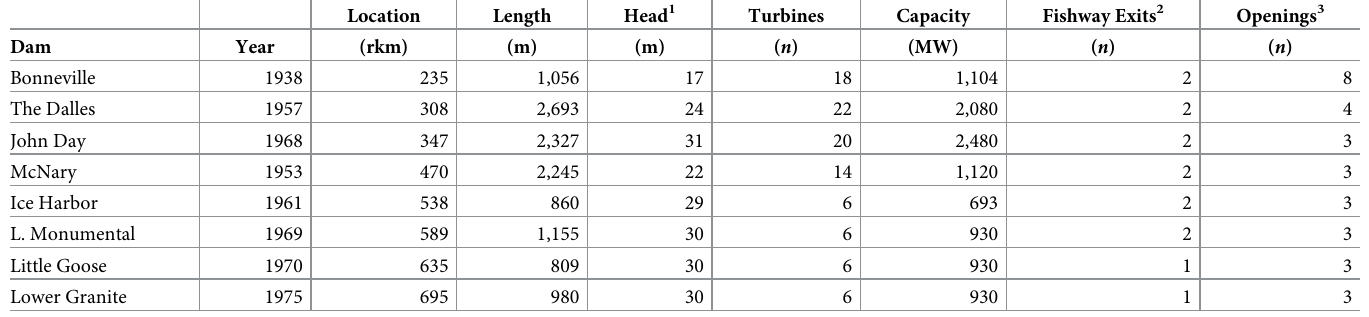
Table 1. Geographic locations and structural details of the four lower Columbia River and four lower Snake River study dams and their fishways. Year = year con- struction was completed. Also see Fig